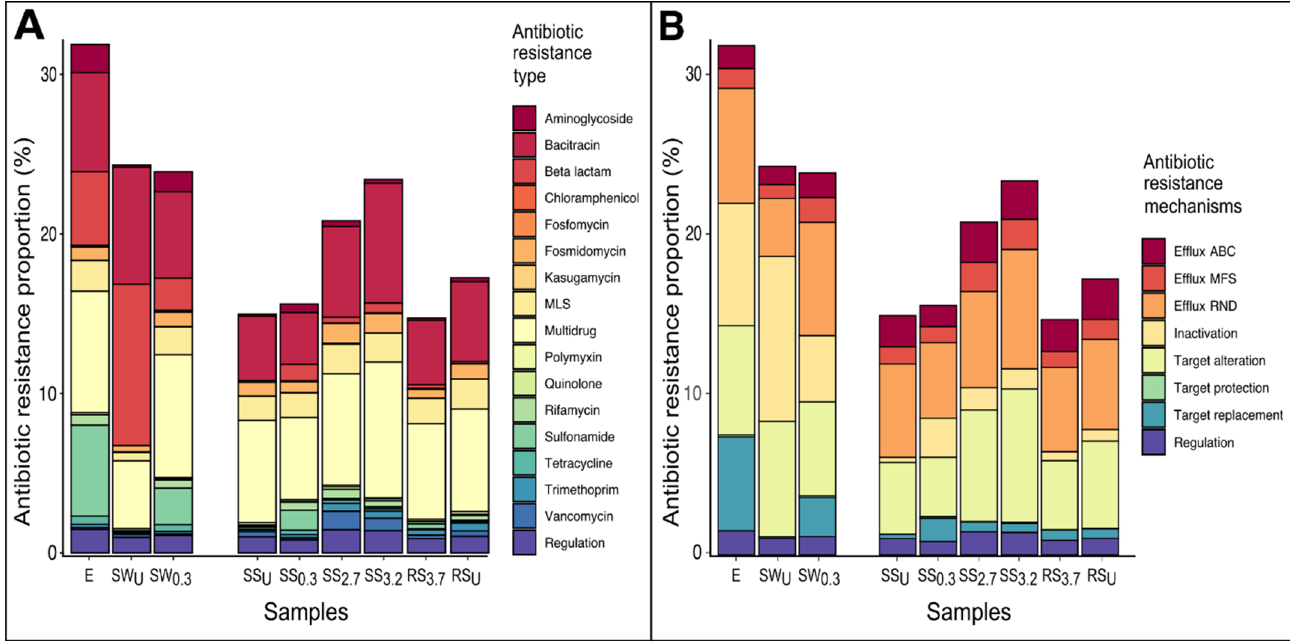
Figure 3. The structure of the resistome presented as the proportions of antibiotic resistance types ( A ) and as proportions of antibiotic resistance mechanisms ( B ) in the studied samples. E is the effluent of the wastewater treatment plant (WWTP), SW and RW are water samples and SS and RS are sediment samples of the stream and river, respectively. SW U and SS U are the samples taken upstream of the WWTP discharge point, and RW U and RS U are the samples taken from the river upstream of the stream inflow point. The number in the subscript of the sample code shows the distance (km) of the sampling point downstream from the WWTP discharge point. MLS—macrolide–lincosamide–streptogramin; ABC—ATP-binding cassette-type efflux complex; MFS—major facilitator superfamily efflux complex; RND—resistance–nodulation–division superfamily efflux complex.